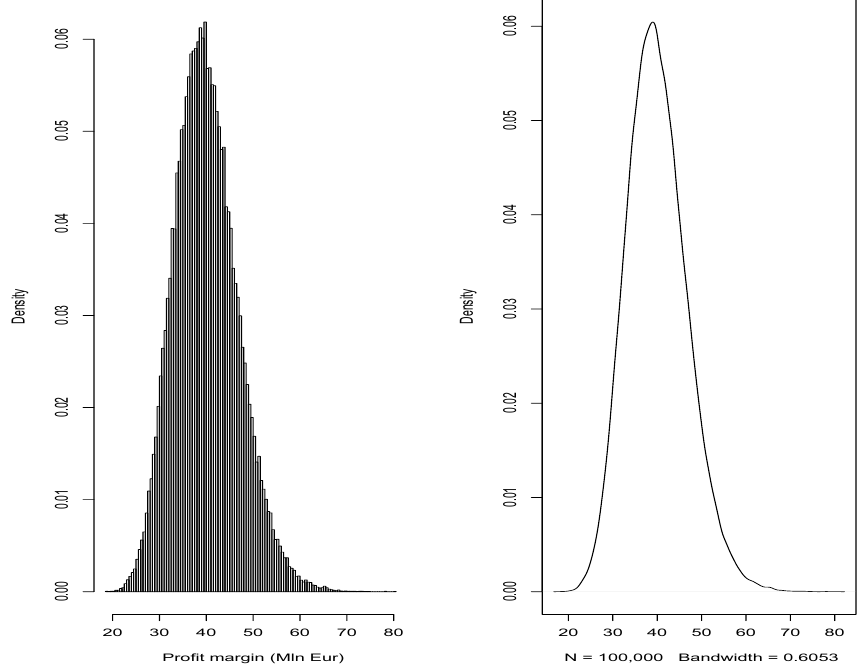
Figure 11. Industrial portfolio market value empirical probability